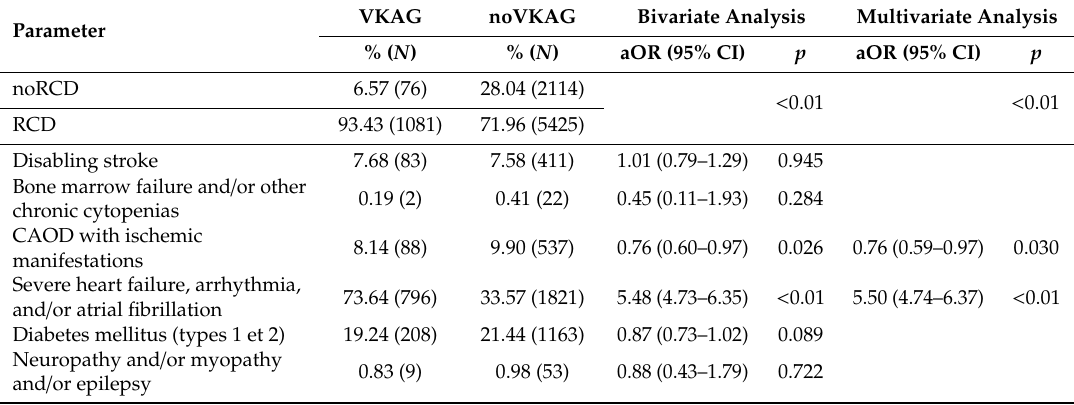
Table 2. Comparison of registered chronic diseases in subjects prescribed or not prescribed vitamin K antagonists, using bivariate and multivariate analyses using logistic regression.